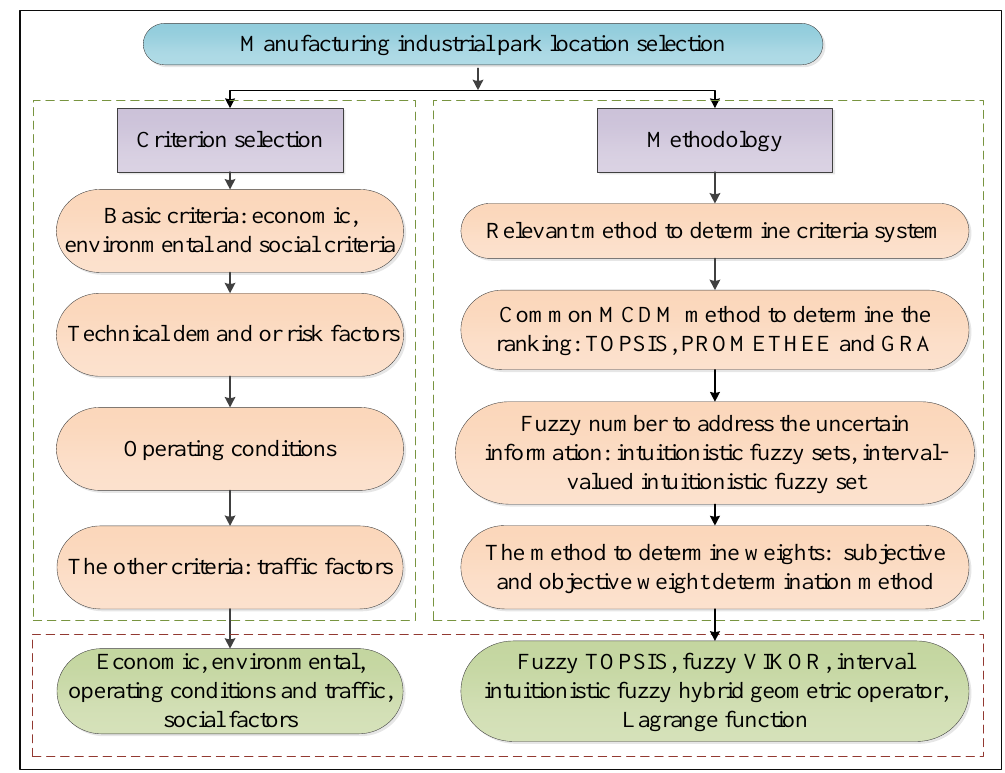
Figure 1. The analysis process of existing research.